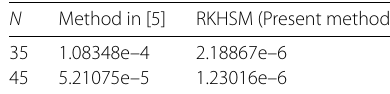
Table 3 Maximum absolute error for Example 3 ( n = 7) N Method in [5] RKHSM (Present method) 35 1.08348e–4 2.18867e–6 45 5.21075e–5